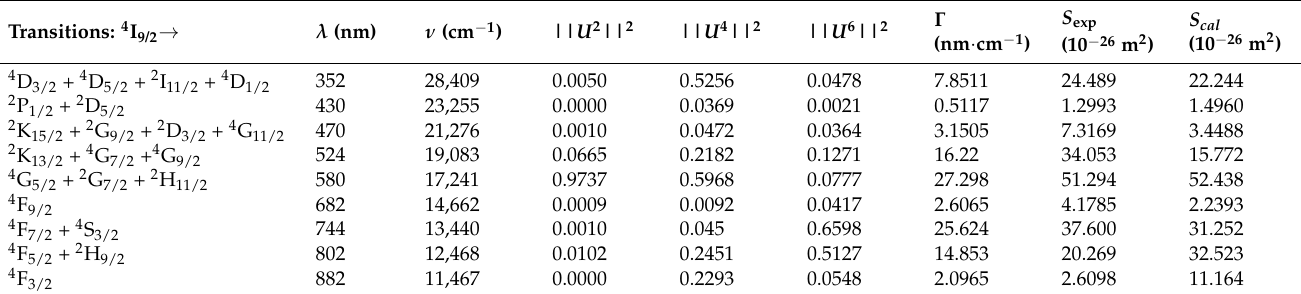
Table 1. The results of the intensity measurements and line strength calculations for absorption